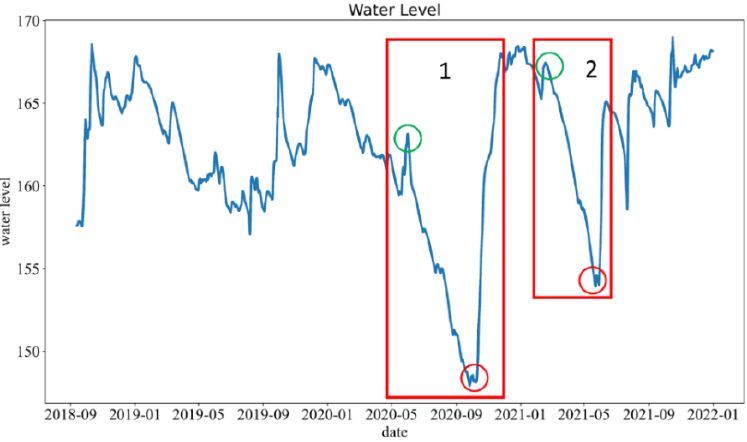
Figure 7. The water level trend of the Feitsui Reservoir.